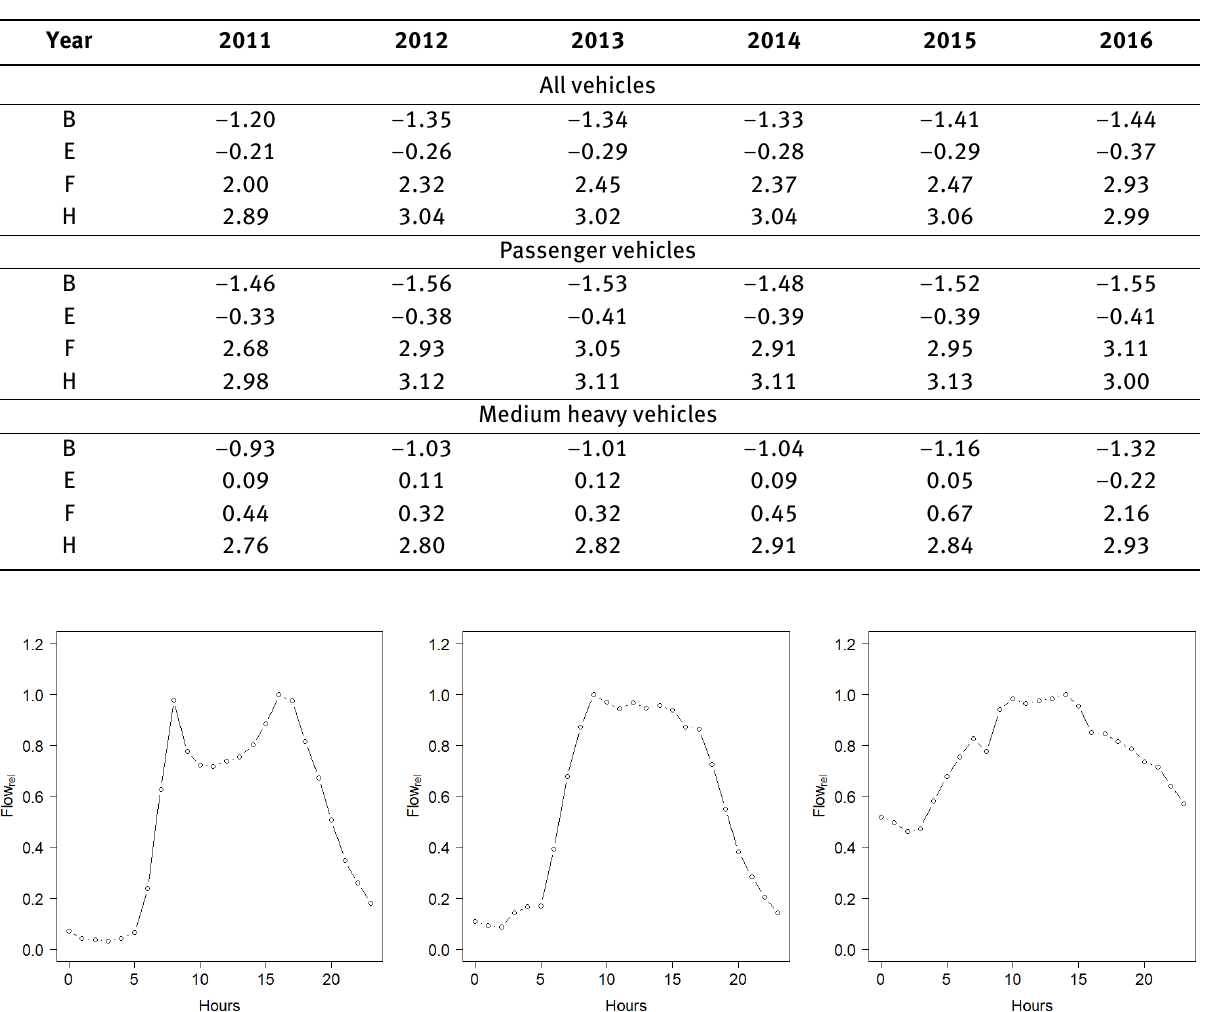
Table 3: Values of the B, E, F, H coeflcients in the equations describing the phases of the model of the normalized annual hourly traflc flow of various groups of vehicles